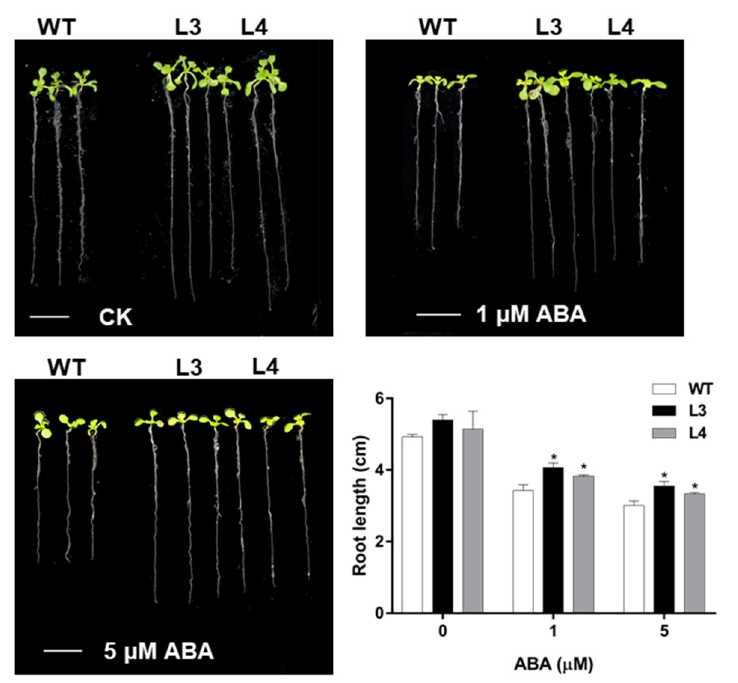
Figure 4. Root elongation analysis of Arabidopsis under ABA treatment. Error bars represent ± SD ( n = 3). Asterisks denote significant differences (as compared with the control group): * p < 0.05.